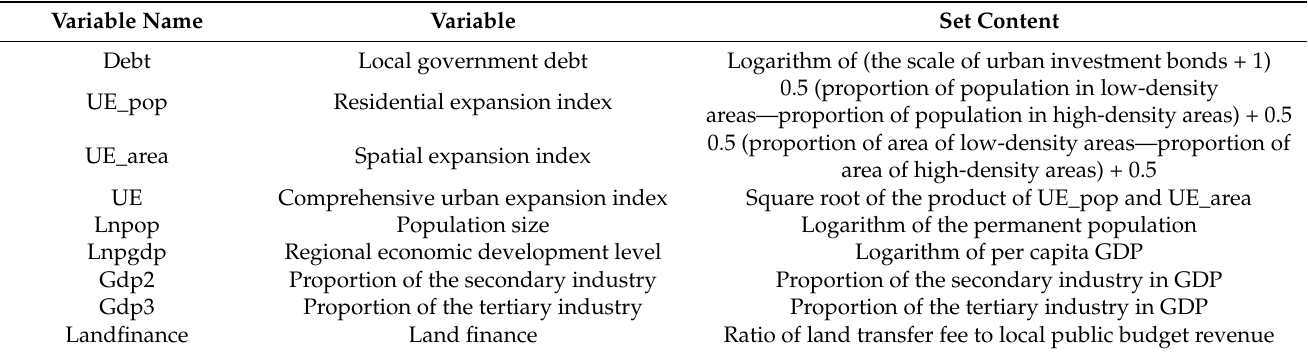
Table 1. Variables and